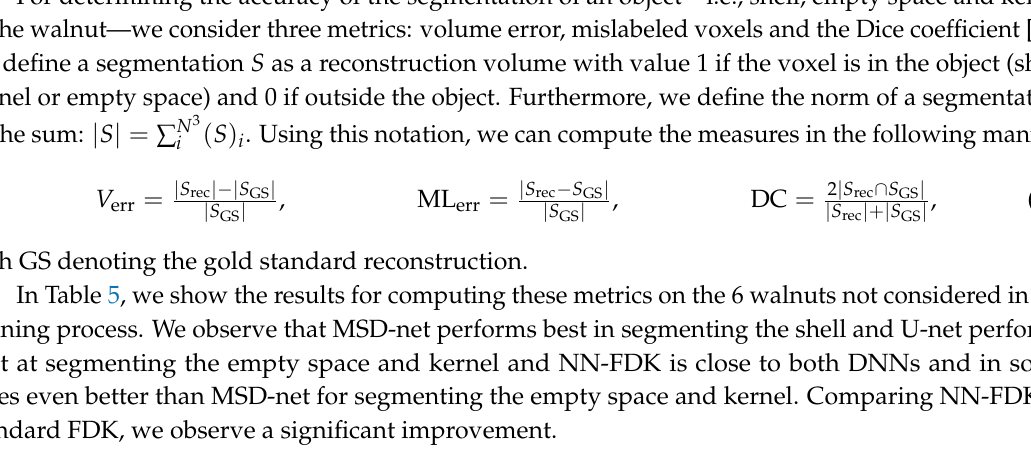
Table 5. The average and standard deviation of the three metrics computed over the 6 low-dose walnut datasets with N a = 500 projection angles. The metrics are computed using (20). The NN-FDK reconstruction time is 4-10 times lower than U-net, MSD-net and approximately 40 times lower than SIRT + 200